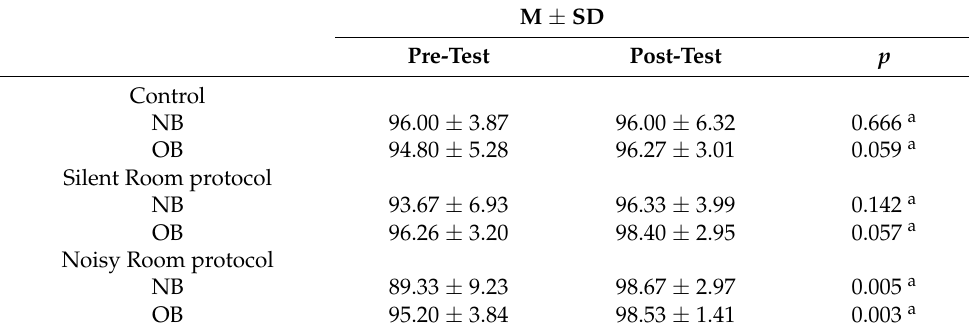
Table 2. Differences between pre-tests and post-tests for each